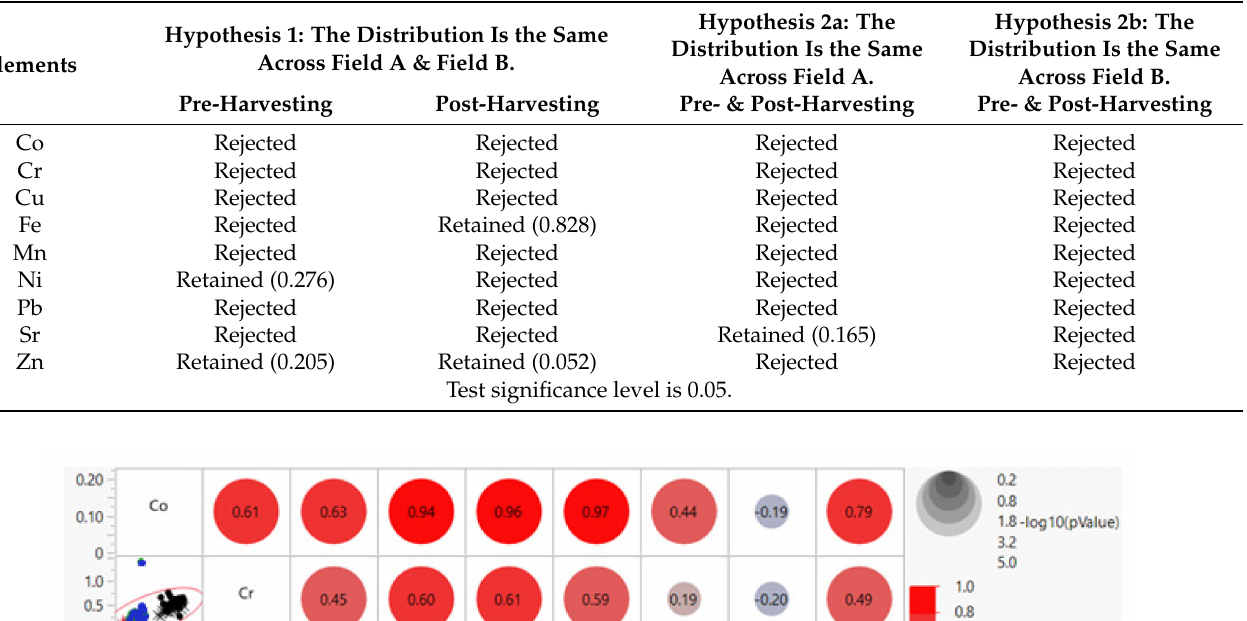
Table 7. Hypothesis Test Summary for Mann–Whitney U-Tests for Field A and Field B—Pre- harvesting and Post-harvesting stages.